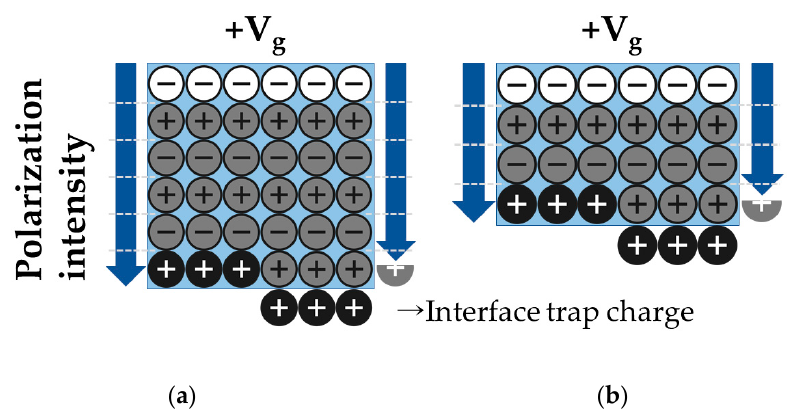
Figure 1. Polarized ferroelectric layers with an interface trap charge (positively charged). Note that the dark blue arrows represent the polarization intensity, and the interface trap charge is drawn outside the sky blue rectangle. The gray circles represent the charge compensation. ( a , b ) show the illustrated schematic of polarized ferroelectric film. The thickness of polarized ferroelectric film in ( b ) is thinner than that in ( a ), and the reduction ratio of polarization intensity by the interface trap in ( b ) is higher than that in ( a ).